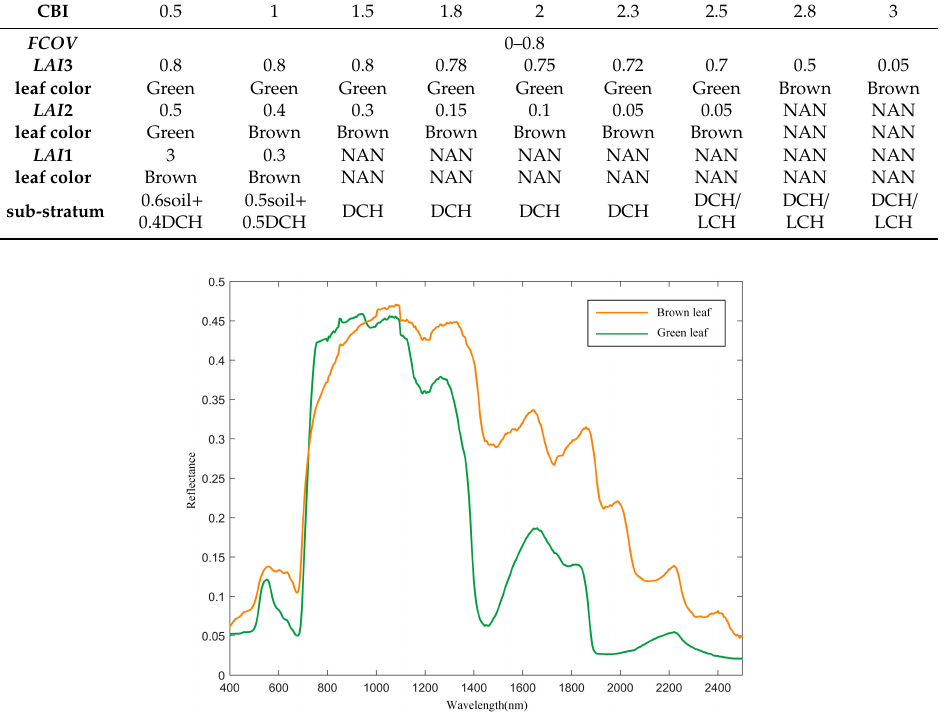
Figure 3. Modeled spectra of brown (brown curve) and green leaf (green curve) used as input for the simulation at canopy level based on the PROSPECT